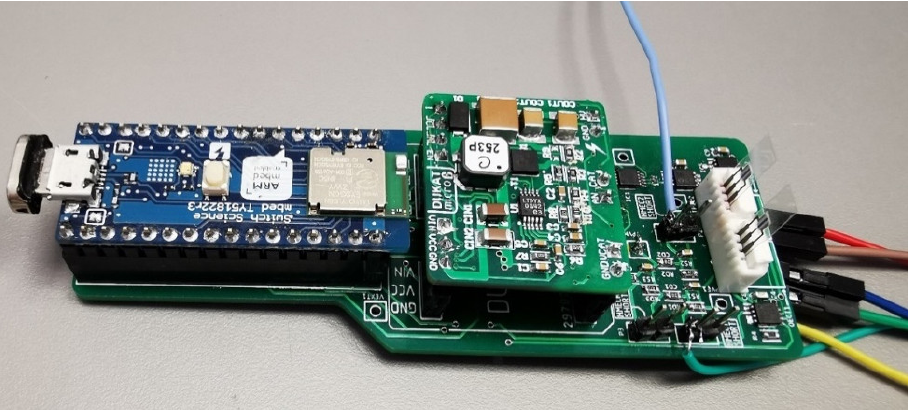
Figure 4. Image of the developed testbed for characterization of OECTs. The Bluetooth and MCU modules are on the blue top board on the left, the DC/DC step up and pulse generator are integrated on the green top board in the middle, and the two printed OECTs tested for their switching capabilities are plugged into the FFC docks on the right. The wires on the right side connect specific points in the test circuit to the oscilloscope for analysis of voltage levels and current propagation .